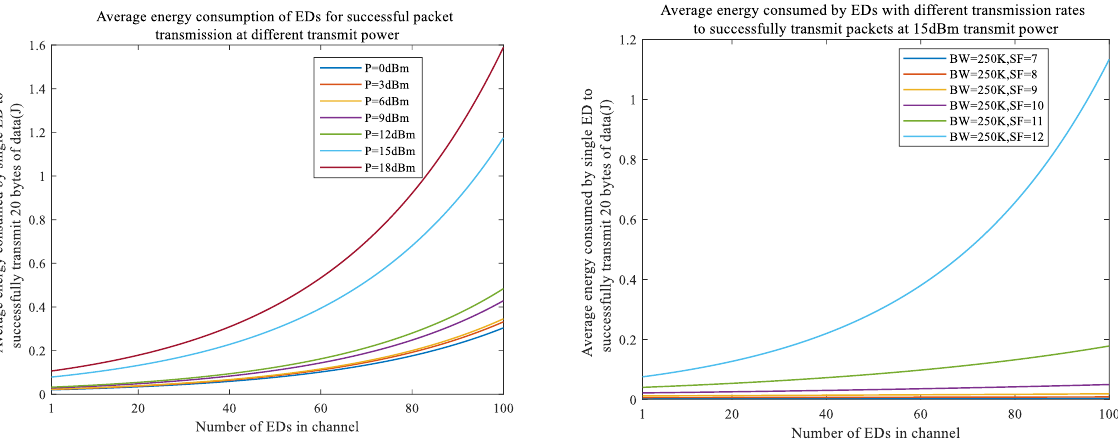
Figure 11. As the number of EDs in the channel increases, the energy consumed by an ED to successfully transmit a frame changes.